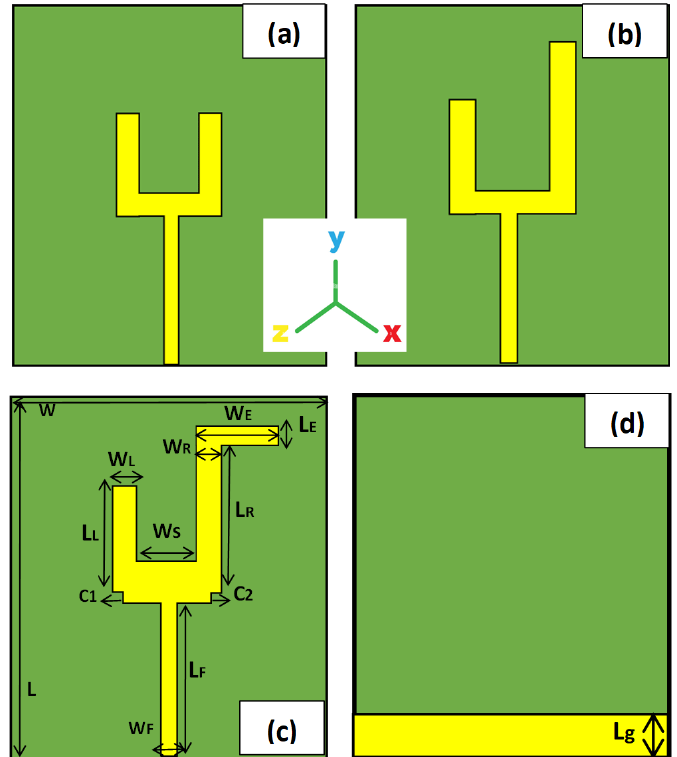
Figure 1. Antenna design evolution: ( a ) Symmetric U-shape, ( b ) A-symmetric U-shape, ( c ) Proposed antenna, and ( d ) Ground plane.